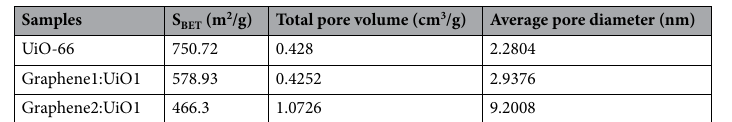
Table 2. Physical properties of adsorbents obtained from BET analysis.